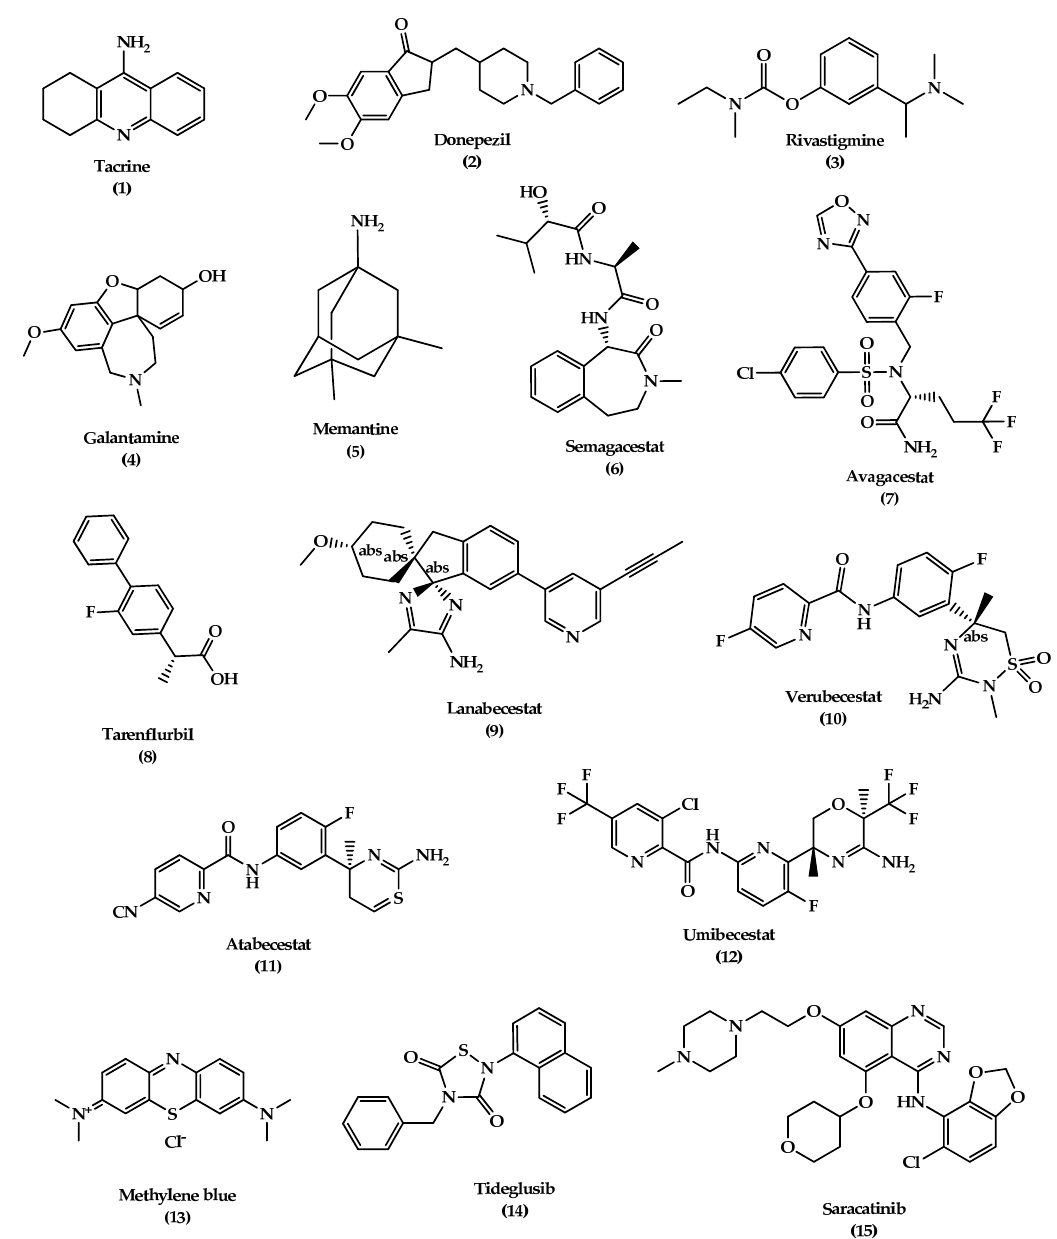
Figure 4. The chemical structures of approved drugs for symptomatic treatment of AD (tacrine 1 , donepezil 2 , rivastigmine 3 , galantamine 4 , and memantine 5 ) and disease-modifying compounds that entered clinical trials (semagacestat 6 , avagacestat 7 , tarenflurbil 8 , lanabecestat 9 , verubecestat 10 , atabecestat 11 , umibecestat 12 , methylene blue 13 , tideglusib 14 , and saracatinibin 15 ).